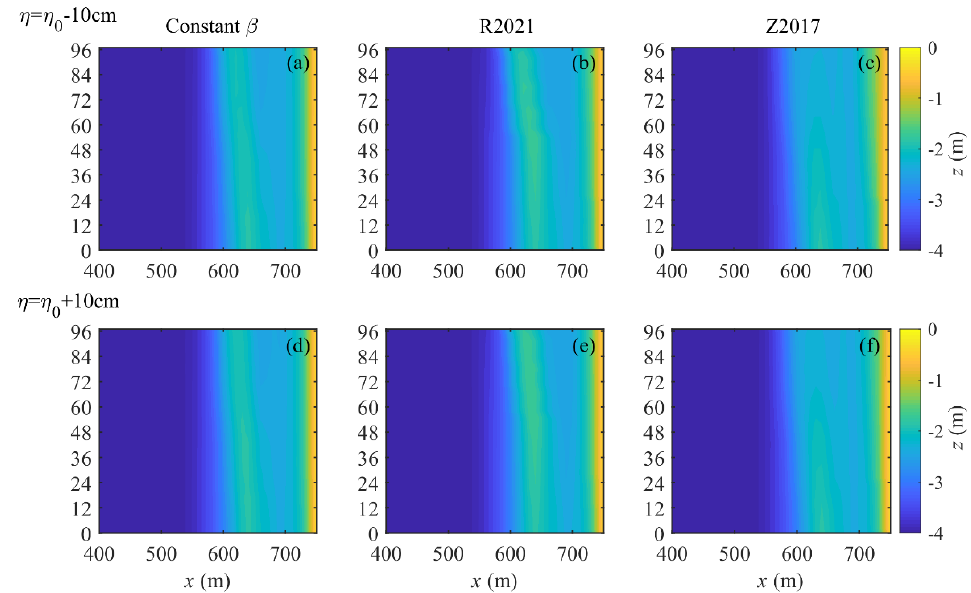
Figure 12. Spatial–temporal evolution of the sandbar predicted by constant roller slope (a, d) and the roller slope of R2021 (b, e) and Z2017 (c, f) under two different sea levels. Figures 12a,b,c are calculated with η 0 -10 cm, and figures 12d,e,f are calculated with η 0 +10 cm.